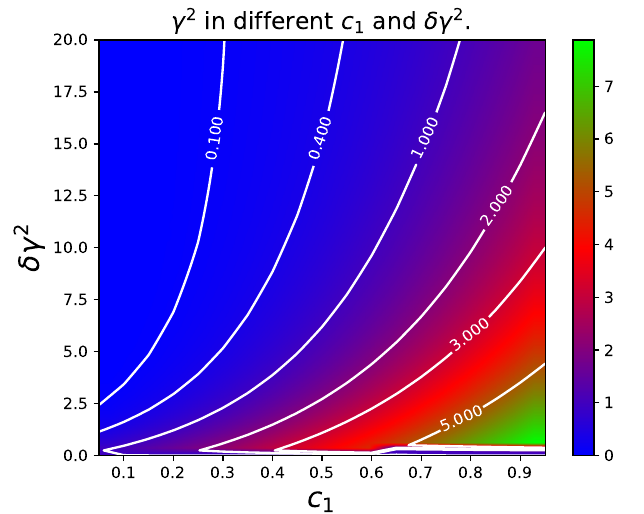
Figure 2 . (cid:13) 2 , which indicates the bound-energy, versus di(cid:11)erent c 1 and (cid:14)(cid:13) 2 . Here c 2 is (cid:12)xed to be 1, and (cid:24) 1 = 200, (cid:24) 2 = 100.